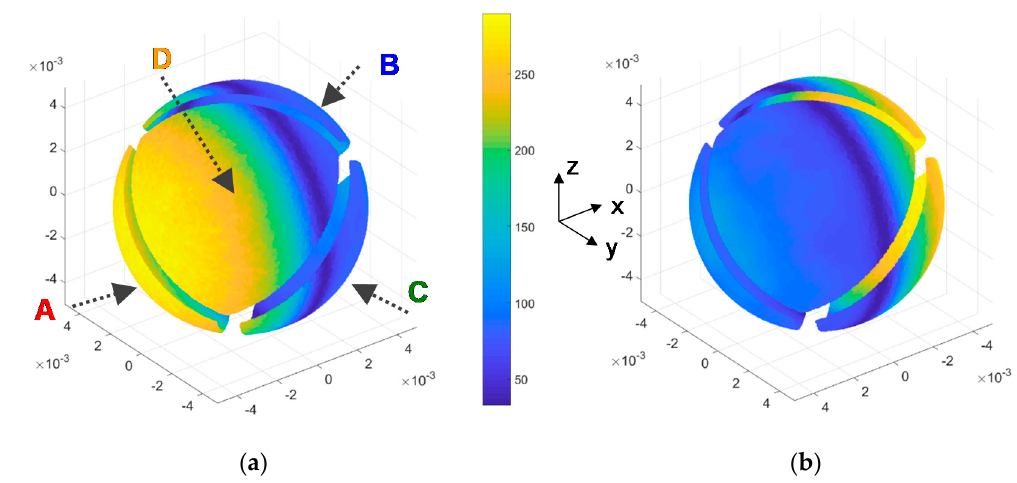
Figure 25. Front view ( a ) and rear view ( b ) snapshots of the convective heat transfer coefficient (W / (m 2 K)) on the sector surfaces of the sphere, obtained from LES at Re = 10,000. The wind direction is parallel to the x -axis. The disposition of the sectors A, B, C and D is the same the one shown previously.